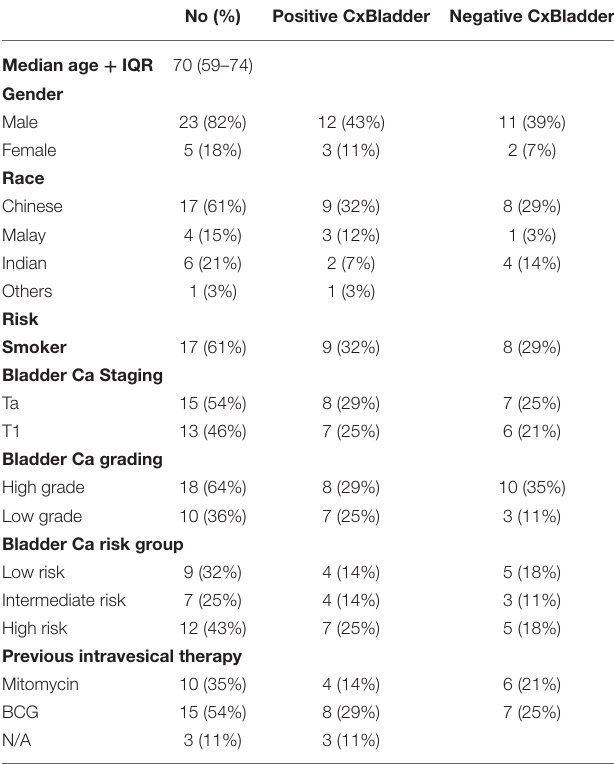
TABLE 1 | Patient demographics of CxBladder surveillance.